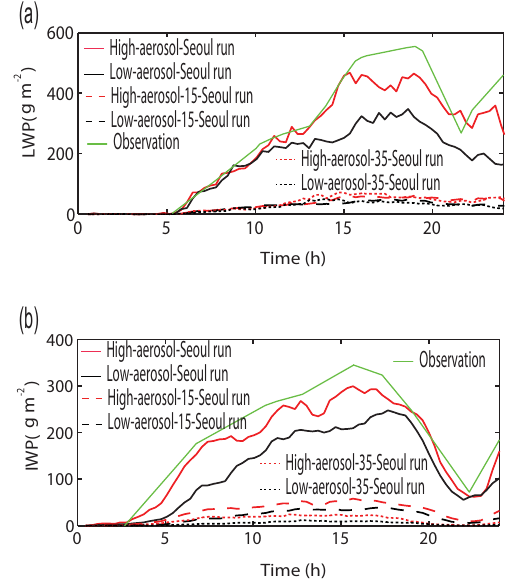
Figure 5. Time series of the domain-averaged (a) liquid water path (LWP) and (b) ice water path (IWP) for the Seoul case. Solid lines represent simulations at the 500m resolution, while dashed and dot- ted lines represent those at the 15 and 35km resolutions, respec- tively. Green lines represent observed LWP and IWP.